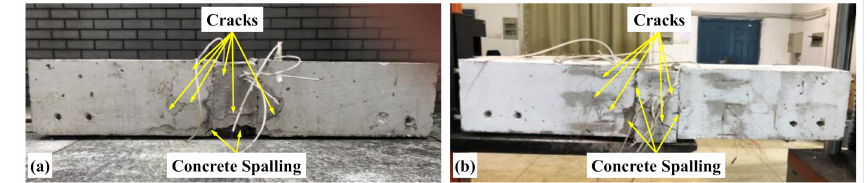
Figure 5. Failure modes of ( a ) S-CWJ and ( b )